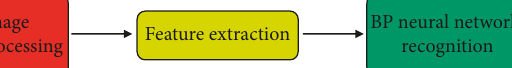
Figure 7: Composition block diagram of the grain pest image recognition